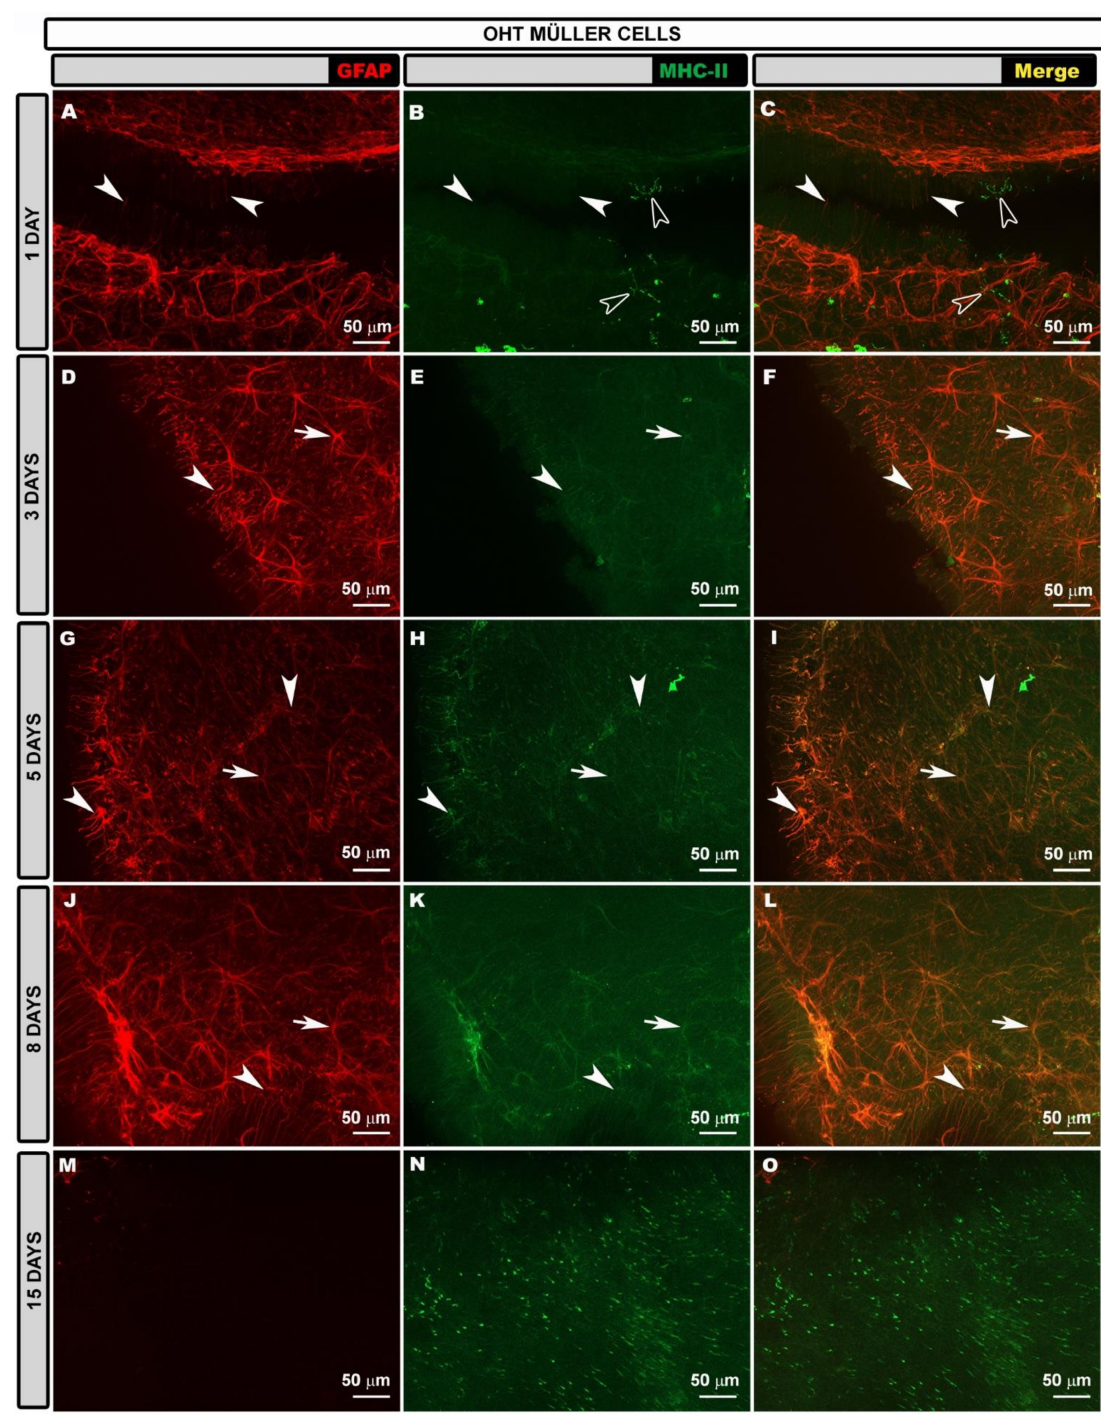
Figure 8. Retinal whole-mount. Double immunostaining for GFAP (red) and MHC-II (green) in Müller glia at different time points after OHT induction in OHT eyes. GFAP-labeled Müller cells are shown at different time points ( A , D , G , J , M ). MHC-II expression in Müller glia (arrow head) was observed at all time points (1 ( B , C ); 3 ( E , F ); 5 ( H , I ); 8 ( K , L ); and 15 ( N , O ) days), being more intense at 15 ( N , O ) days after laser treatment, being as intense as that of dendritic cells (hollow arrowhead). Arrows point to MHC-II+ astrocytes. GFAP: glial fibrillary acidic protein; MHC-II: major histocompatibility complex class II; OHT: ocular